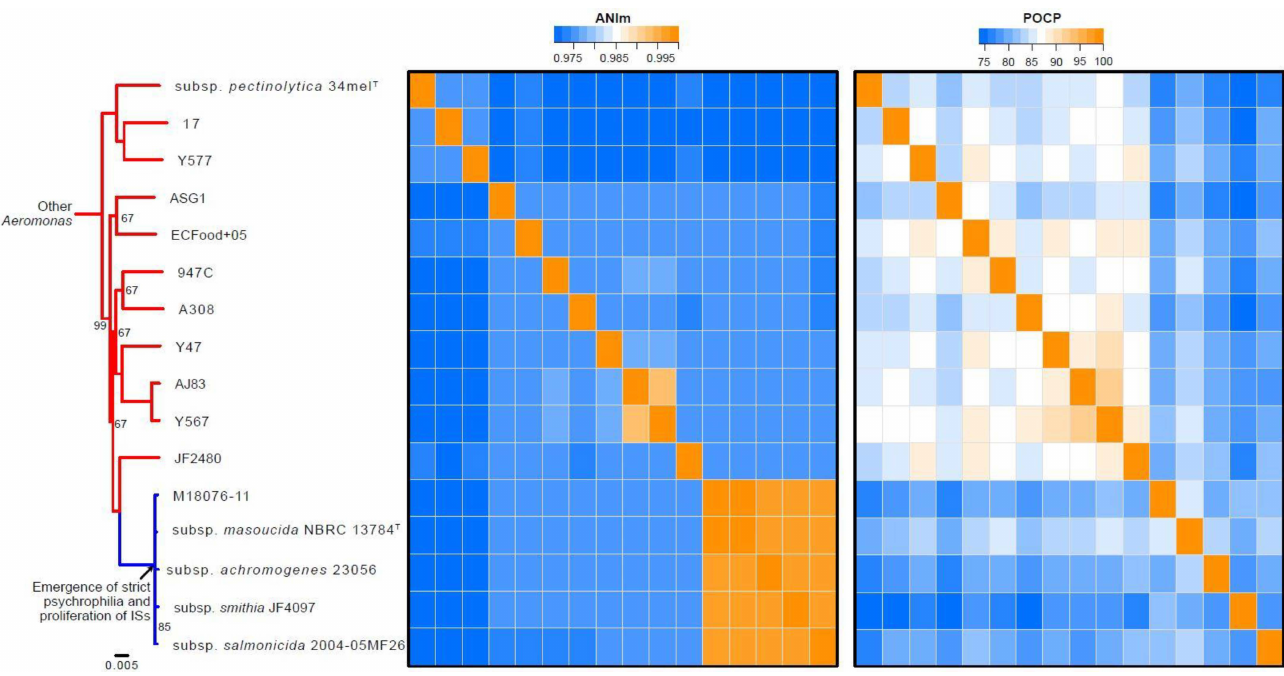
Figure 1. Molecular phylogeny, based on softcore genes, and matrices of ANI and POCP values. The analyses were performed as previously described [20]. Only bootstrap values below 100 are shown. Mesophilic strains are indicated in red and strict psychrophilic strains in blue. The subspecies are indicated when known, otherwise only the names of the strains are reported. All genomic sequences are publicly available on GenBank and the BioSample numbers are: A. salmonicida subsp.